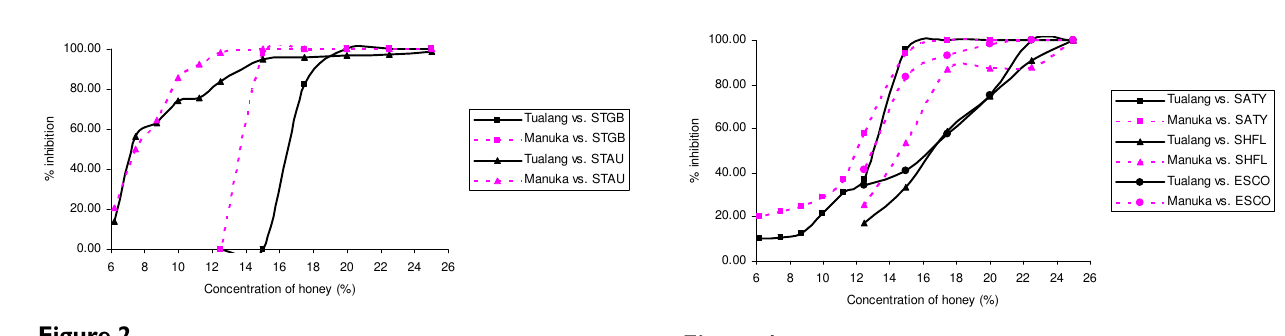
Figure 4 Inhibition of the growth of S. typhi (SATY), S. flexneri (SHFL) and E. coli (ESCO) .